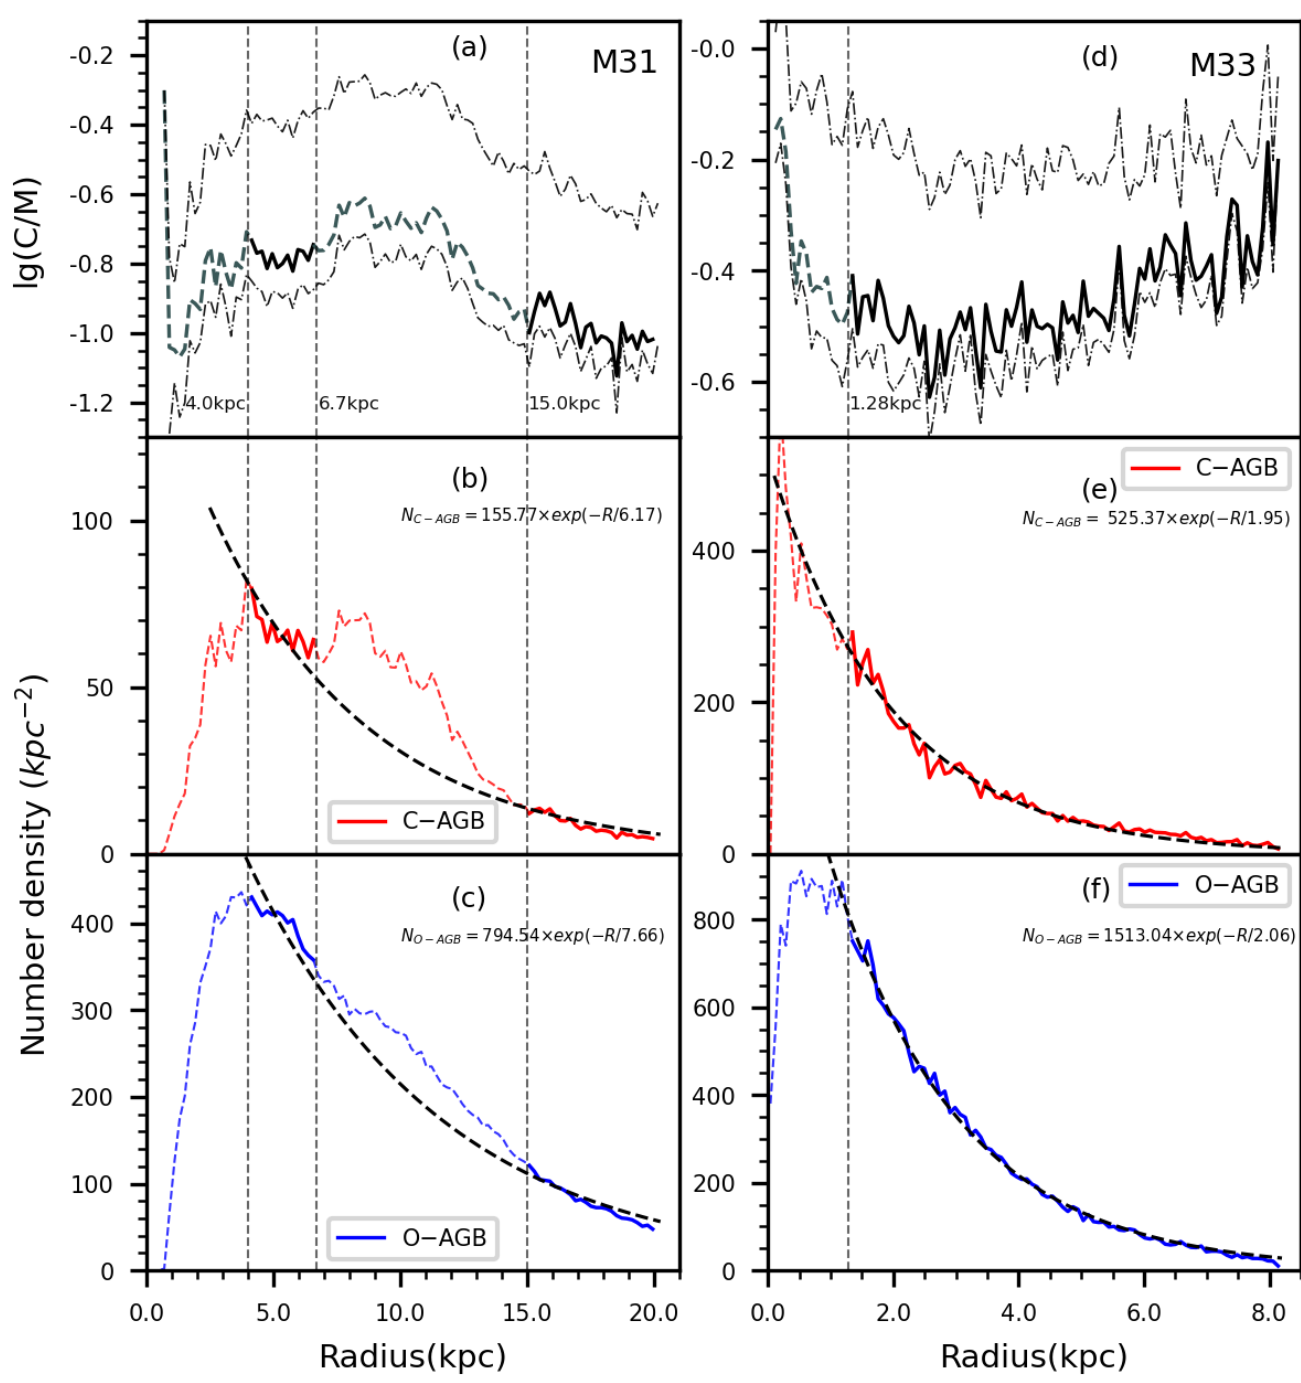
Figure 8. The radial distribution of the C/M ratio, C-AGB stars and O-AGB stars in M31 (panel a,b,c), and in M33 (panel d,e,f). An exponential function is used to fit the radial distribution of C-AGBs and O-AGBs with the results displayed, where the region with uncertain photometry and locate in the ring area in M31 are not used and labelled by the dashed line. Besides, the 50% confidence limits of the C/M ratio are represented with dashed-dot lines on both sides of the C/M ratio median